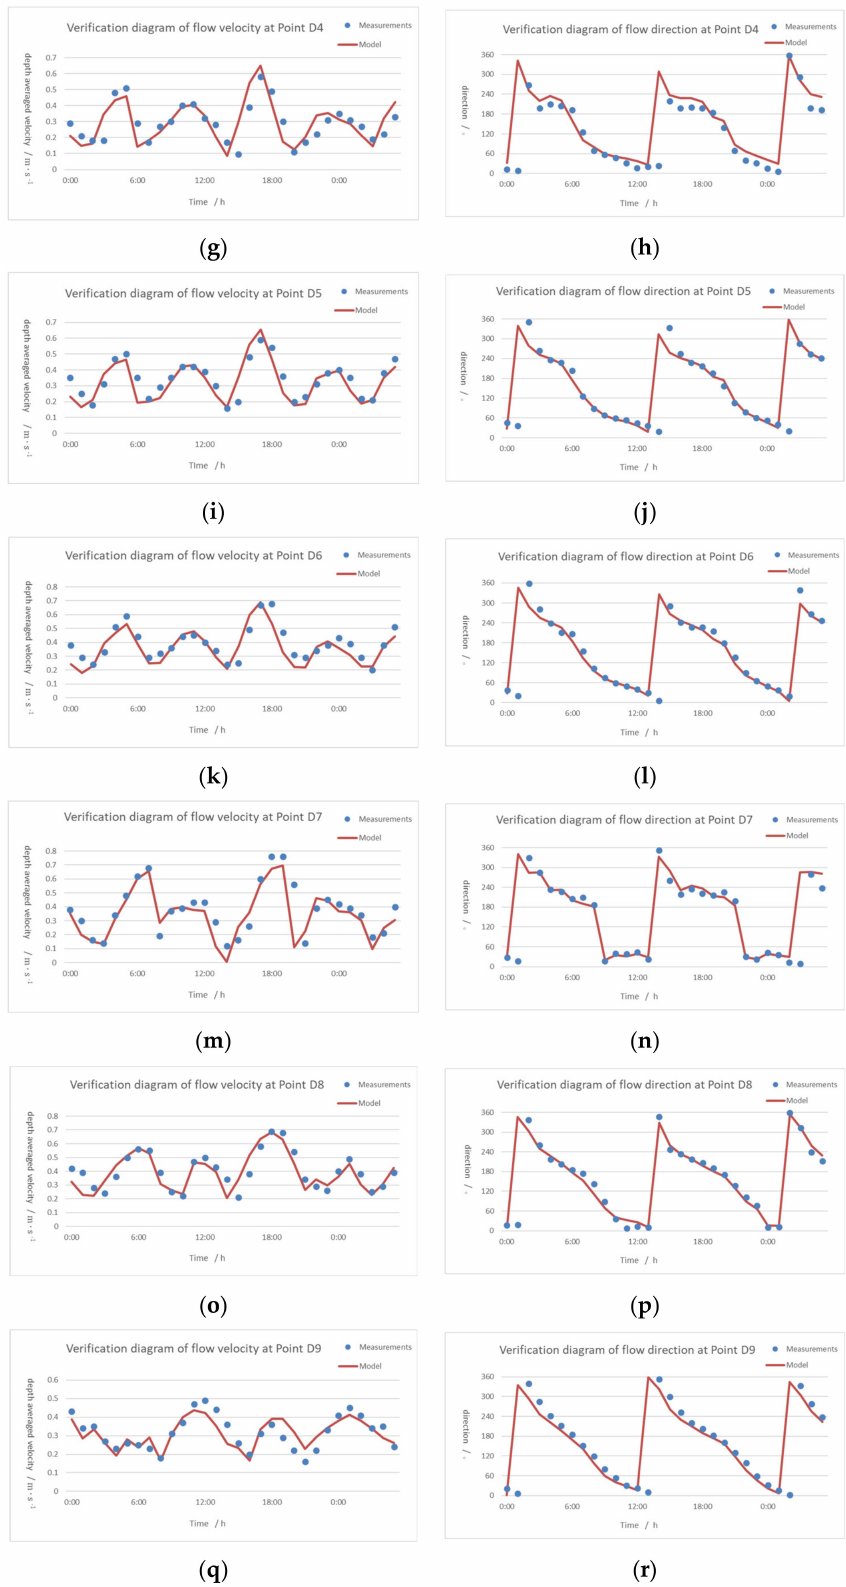
Figure 5. Tide current verification in 2006. ( a ) Verification diagram of flow velocity at Point D1; ( b ) Verification diagram of flow direction at Point D1; ( c ) Verification diagram of flow velocity at Point D2; ( d ) Verification diagram of flow direction at Point D2; ( e ) Verification diagram of flow velocity